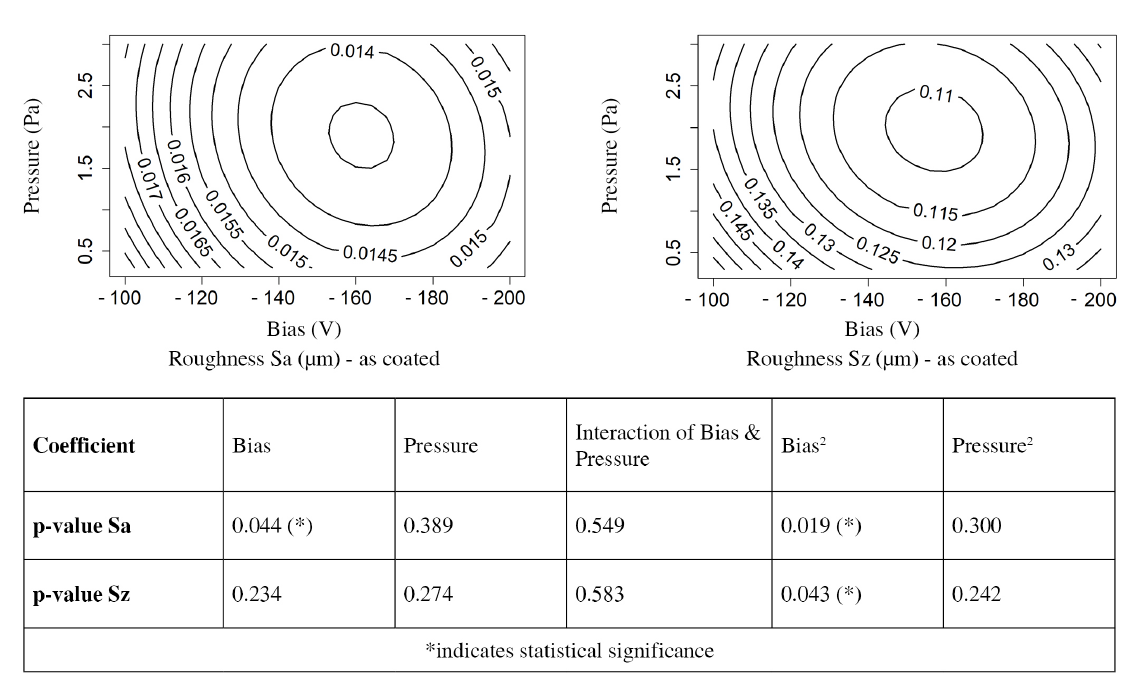
Figure 6. Scatter plot and response surface of surface roughness Sa and Sz (as coated).